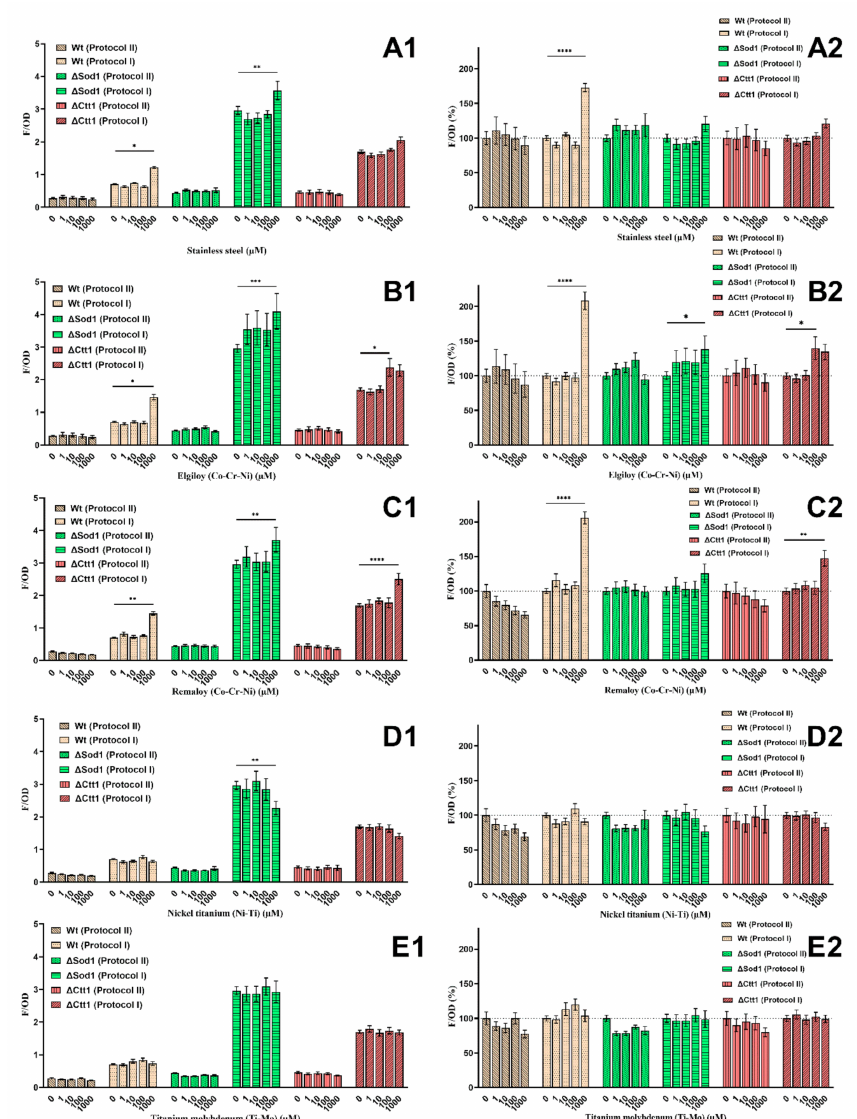
Figure 3. Intracellular oxidation performed with two di ff erent methods for wild-type yeast and two yeast mutants ∆ Sod1 and ∆ Ctt1, and metal treatment: stainless steel ( A ), cobalt-chromium Elgiloy ( B ) and Remaloy ( C ), nickel-titanium ( D ) and β -titanium ( E ). Grouped columns represent either absolute values ( A1 – E1 ) or relative values according to the untreated control group ( A2 – E2 ). For each yeast strain, the untreated control group represents 100% (dotted line). Significant di ff erences ( p < 0.05) are indicated with * (* p < 0.05, ** p < 0.01, *** p < 0.001, and **** p <